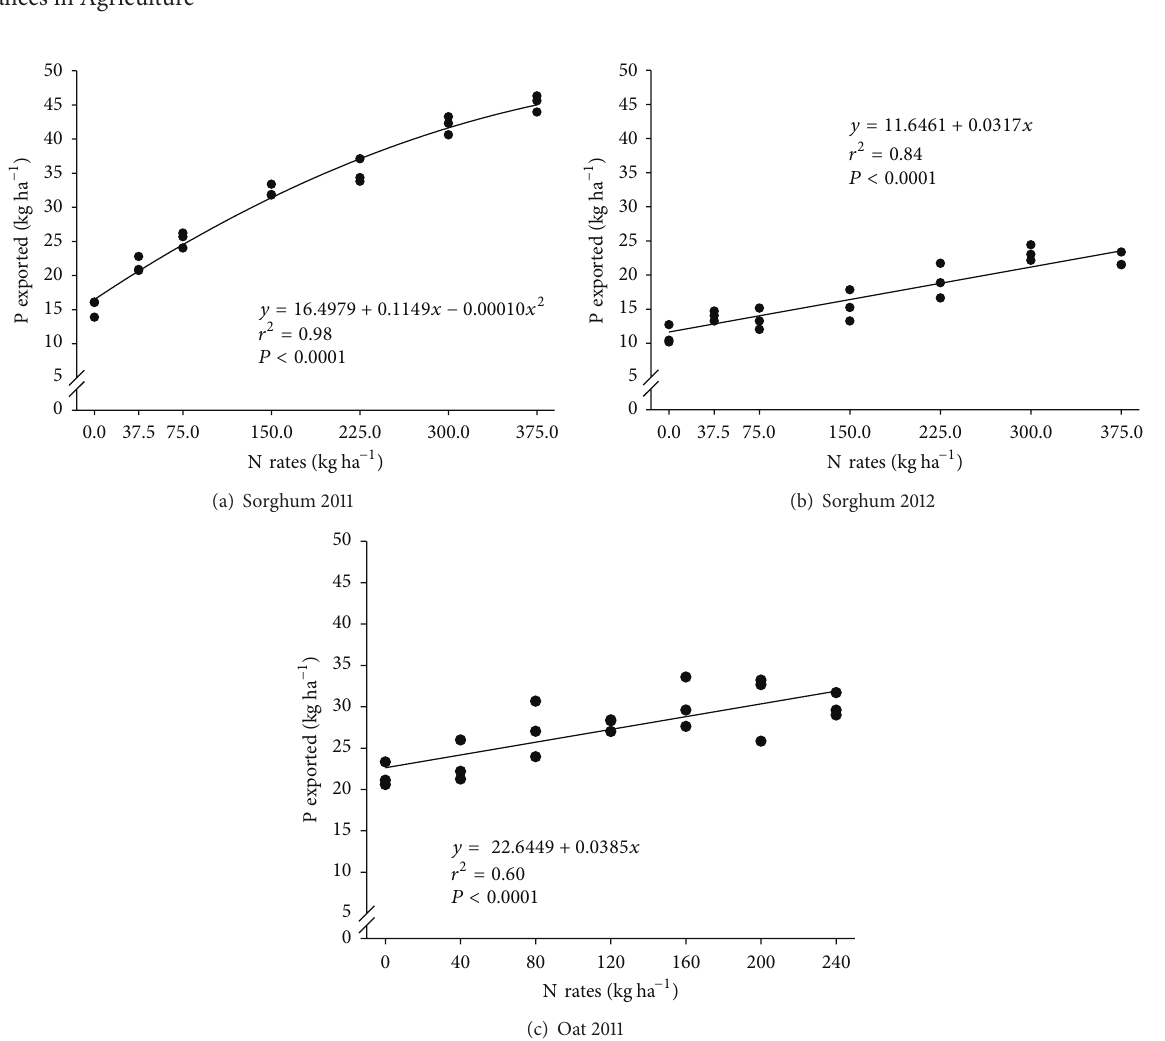
Figure 7: Phosphorus exported by the forage harvested of sorghum in the summer seasons of 2010/2011 (a) and 2011/2012 (b) and black oat in the winter season of 2011 (c), under nitrogen